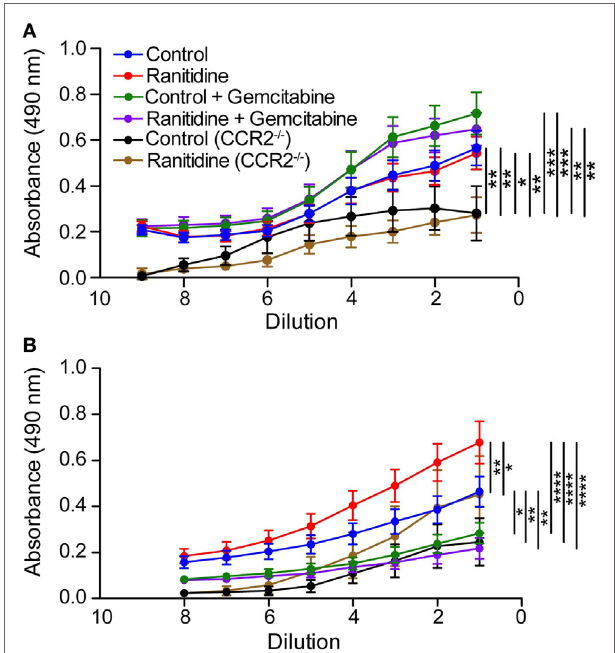
FigUre 2 | Ranitidine significantly enhanced levels of IgG2a capable of binding to E0771-GFP cancer cells. Serum was diluted 1:10 and added to cultured E0771-GFP cells and anti-isotype antibodies for IgG2a (a) or kappa light chain (B) were added. Relative fluorescence intensity (RFI) was used as an indicator for antibody binding to E0771-GFP cells relative to the average of control MFI. Box plot represents mean and range of data from 20 to 24 individual mice. * p < 0.05, unpaired t -test.